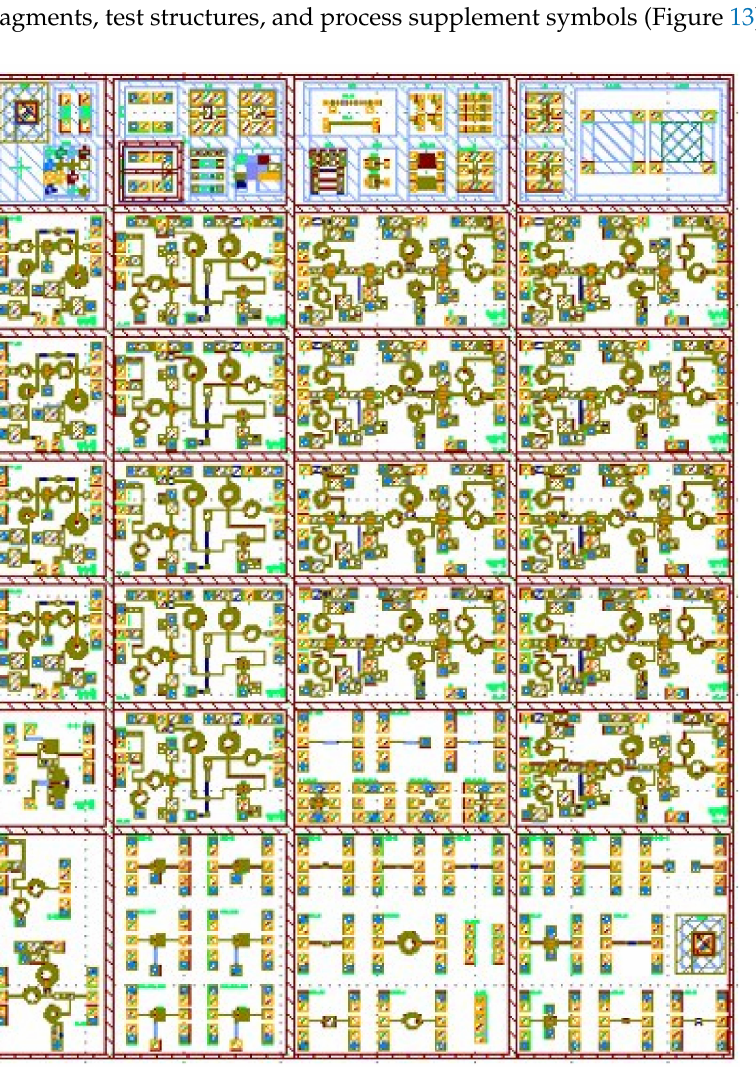
Figure 13. The composed frame (7.7 mm × 10.2 mm) that contains three LNAs, different line fragments, and test